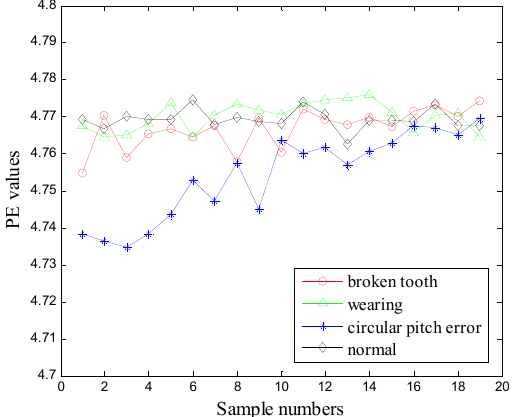
Figure 34. The permutation entropies of original signals.